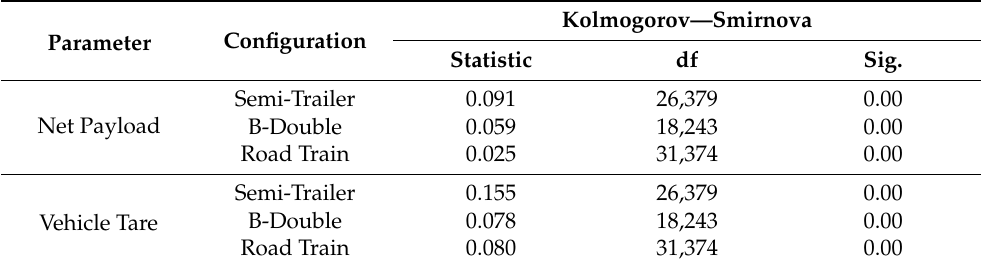
Table 4. Kolmogorov–Smirnov test results.